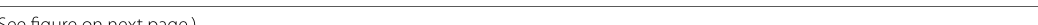
figure on next Fig. 1 A: Unrooted phylogenetic tree of the DCL protein related to higher plants. B: The tree was rooted with the outlier (outgroup A. protothecoides DCL protein). The Phylogenetic relationship was inferred from full-length polypeptide sequences of the plant DCL proteins using the Maximum Likelihood method and JTT model [19] with log likelihood of 18013.10. The percentage of trees in which the associated taxa clustered − together in the bootstrap test (500 replicates) is shown as a symbol displayed on each branch (Felsenstein, 1985). Initial tree(s) for the heuristic search were obtained automatically by applying Neighbor-Joining and BioNJ algorithms to a matrix of pairwise distances estimated using the JTT model. Topology with superior log likelihood value was selected. A discrete gamma distribution was used to model evolutionary rate differences among sites (2 categories ( G , parameter 1.6882)). The rate variation model allowed some sites to be evolutionarily invariable ([ I ], 1.53% sites). + = + The tree is drawn to scale, with branch lengths measured in the number of substitutions per site. This analysis involved 275 polypeptide sequences from Eudicotyledons (242) and Liliopsida (31) and Klebsormidium nitens and A. protothecoides DCL polypeptide sequences used as outlier. All positions containing gaps and missing data were eliminated (complete deletion option). 131 positions in the final dataset was seen. Evolutionary analyses were conducted in MEGA11 and visualized by iTOL v5 online tool